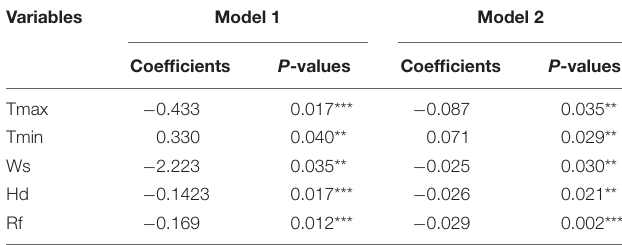
TABLE 4 | Short-run coefficients.